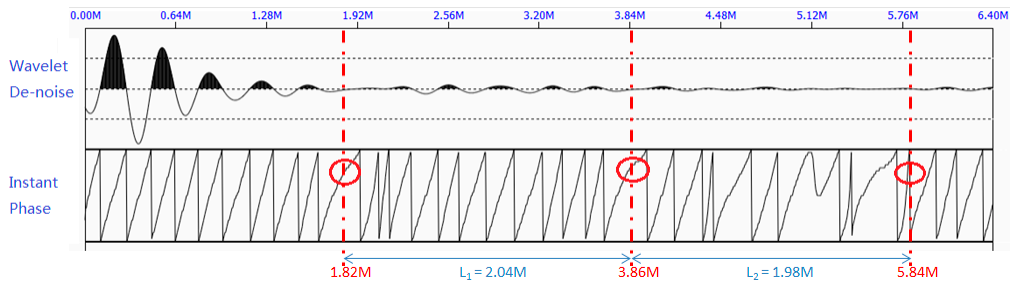
Figure 12. The denoised waveform by wavelet denoising algorithm (top) and the periodic pattern of the instant phase (bottom) at Site 1.